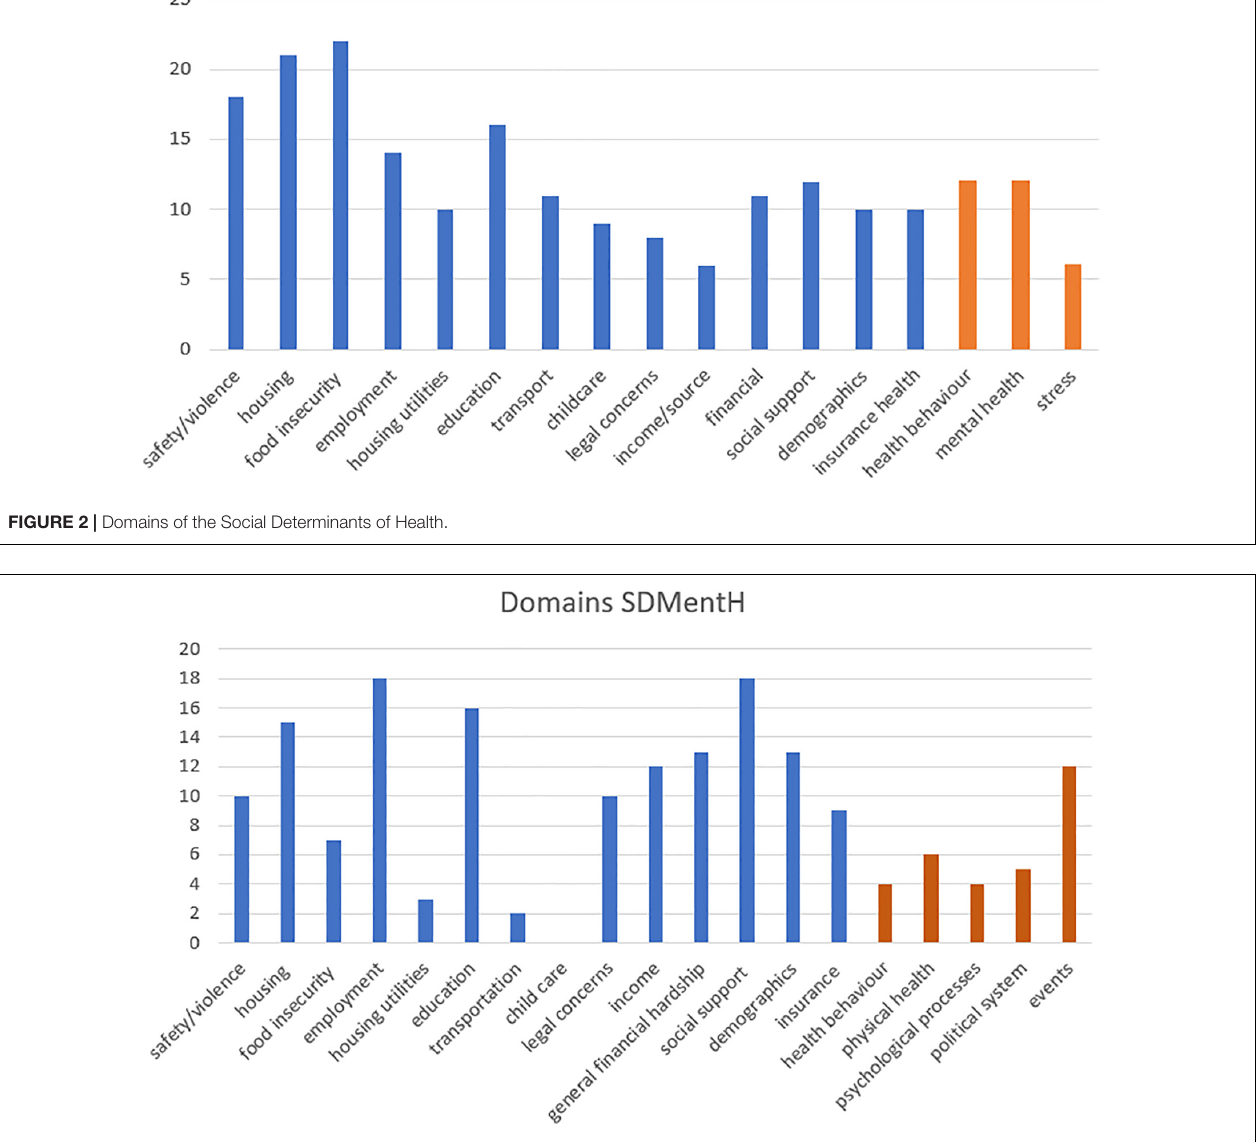
FIGURE 3 | Domains of the Social Determinants of Mental